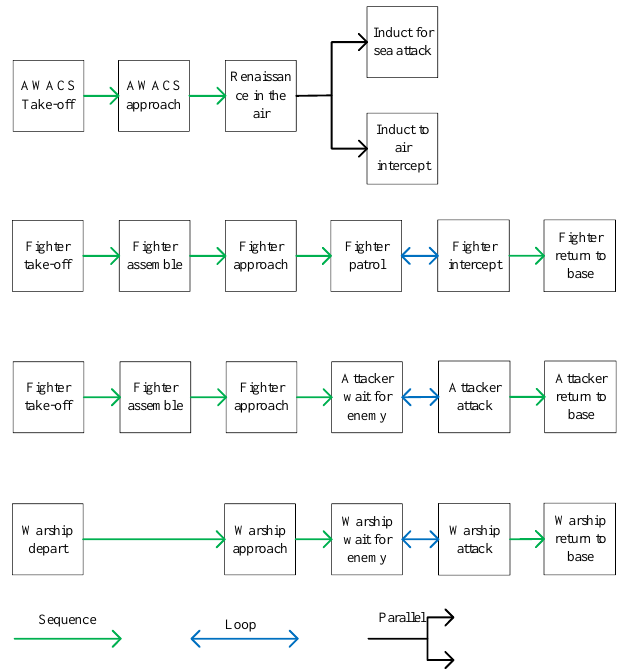
Figure 4. The execution structure of air – sea jointed anti-sea assault missions. (2) Scene analysis.